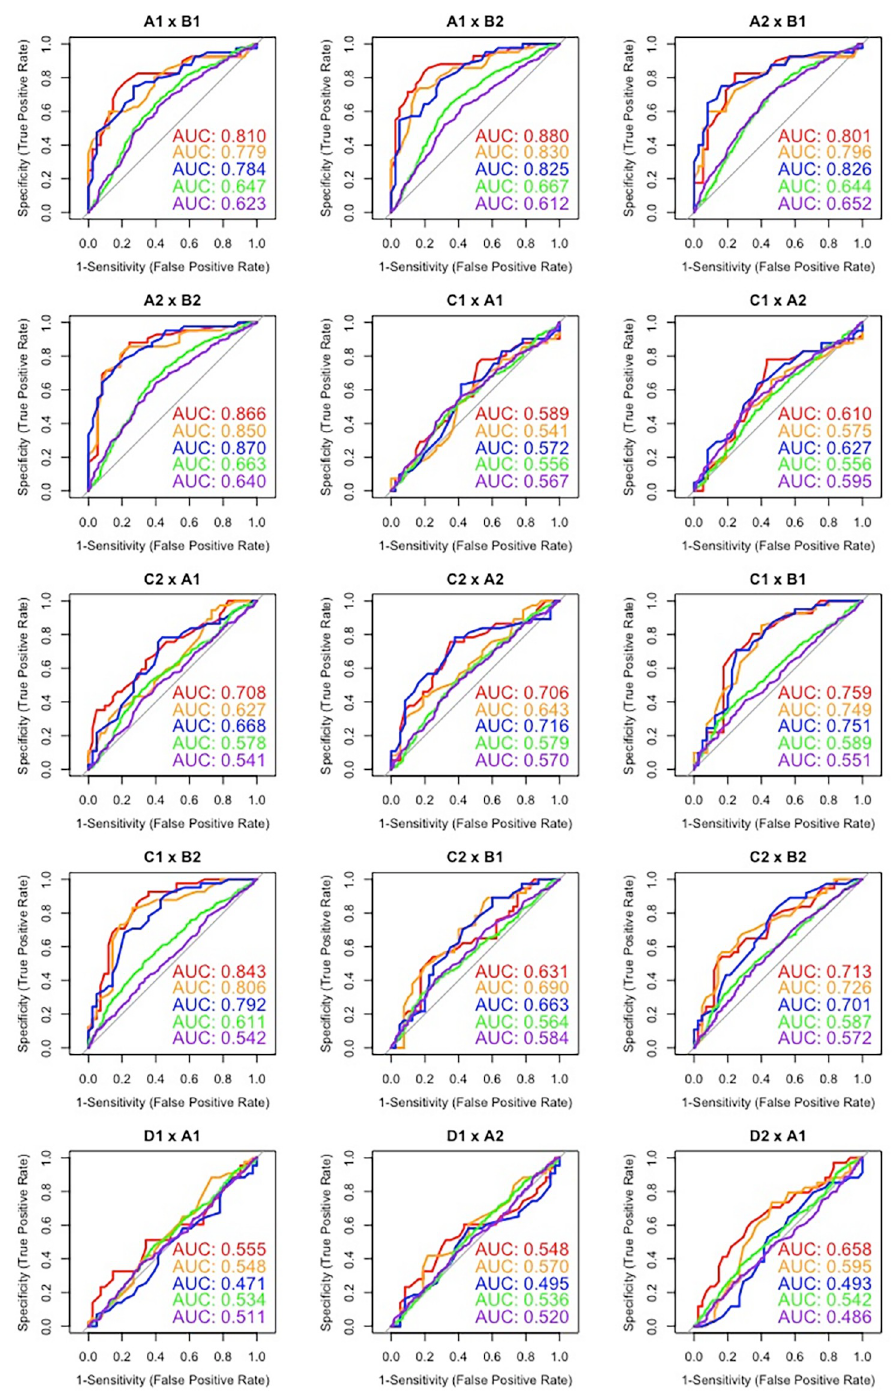
Fig 4. ROC curves and AUC values for cross-pair comparisons